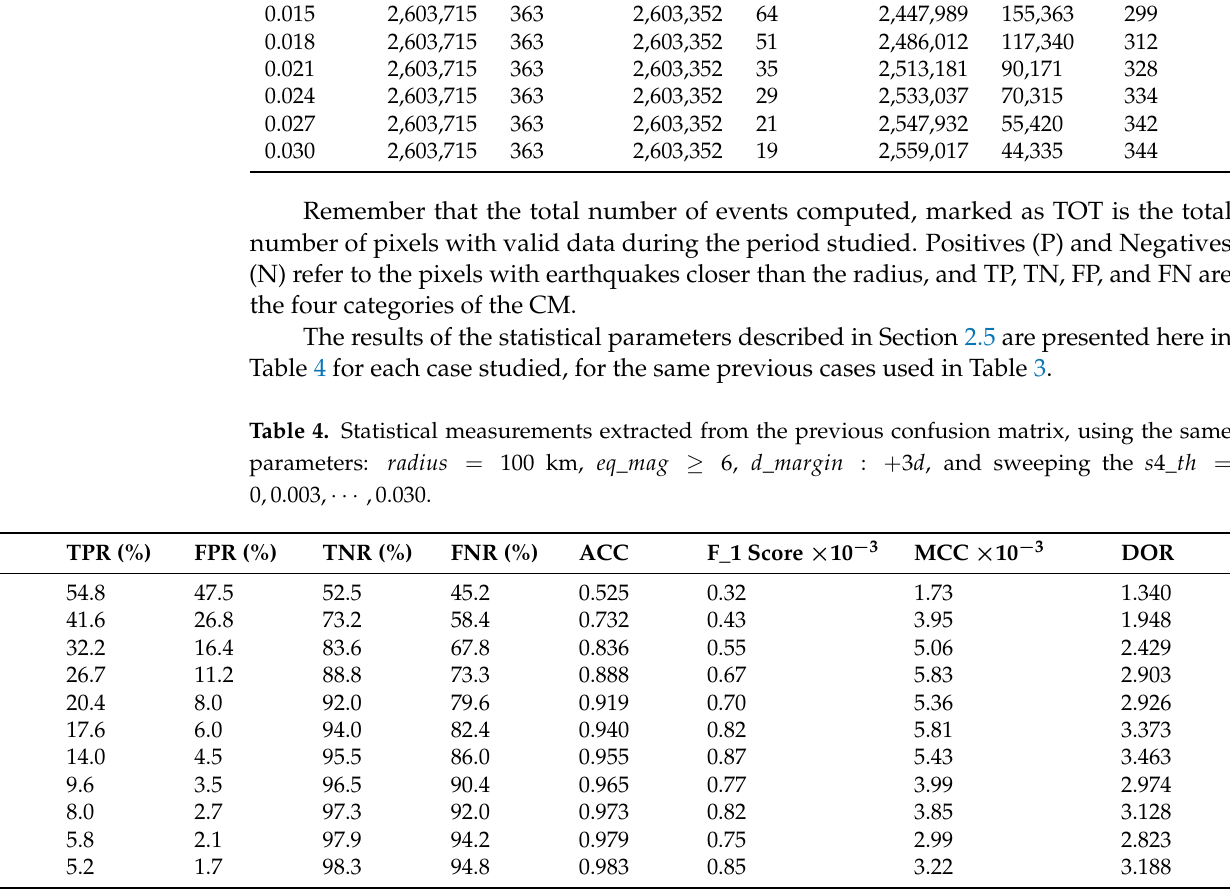
Table 3. Confusion matrixes for several values of the ∆ S 4 threshold, showing the total number of events (TOT), Positives (P), Negatives (N), True Positives (TP), True Negatives (TN), False Positives (FP), and False Negatives (FN), using data from 180 days. s4_th TOT